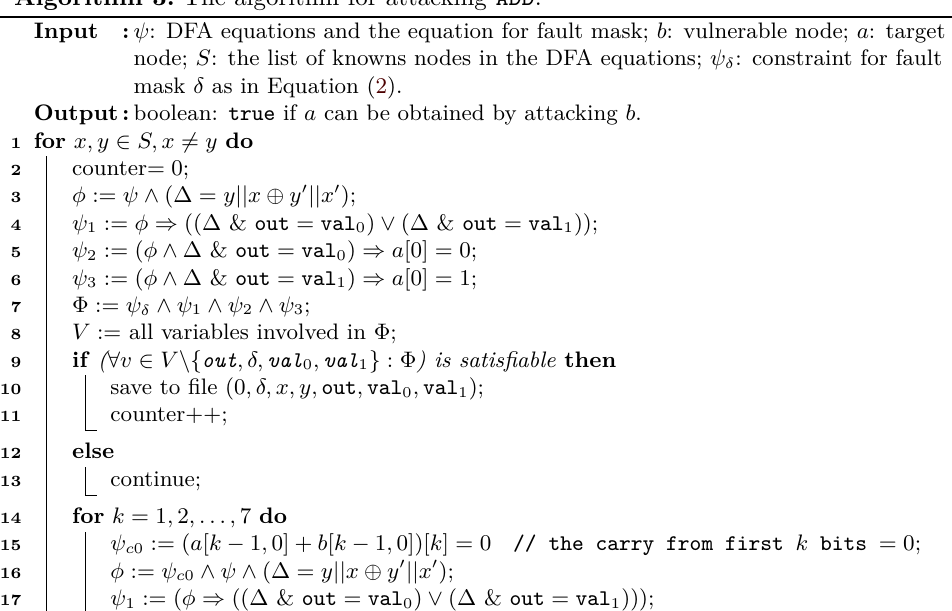
Algorithm 3: The algorithm for attacking ADD